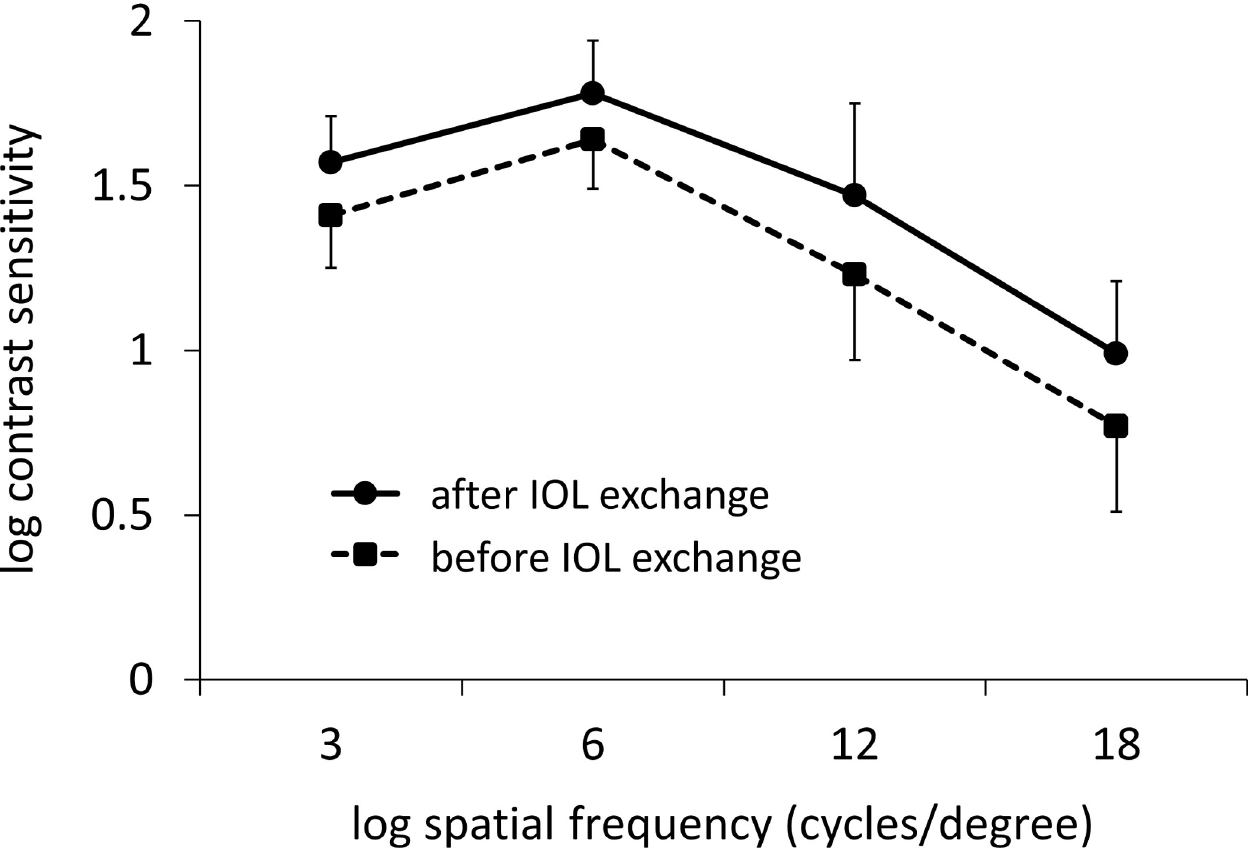
Fig 1. Contrast sensitivity at 5 spatial frequencies before and after intraocular lens (IOL) exchange. IOL exchange induced a significant increase in contrast sensitivity at all spatial frequencies after surgery. Bar represents standard deviation.